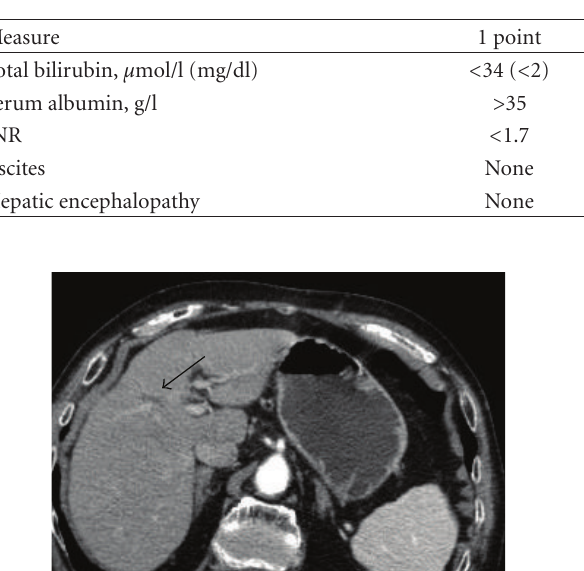
Table 1: Child-Pugh score.